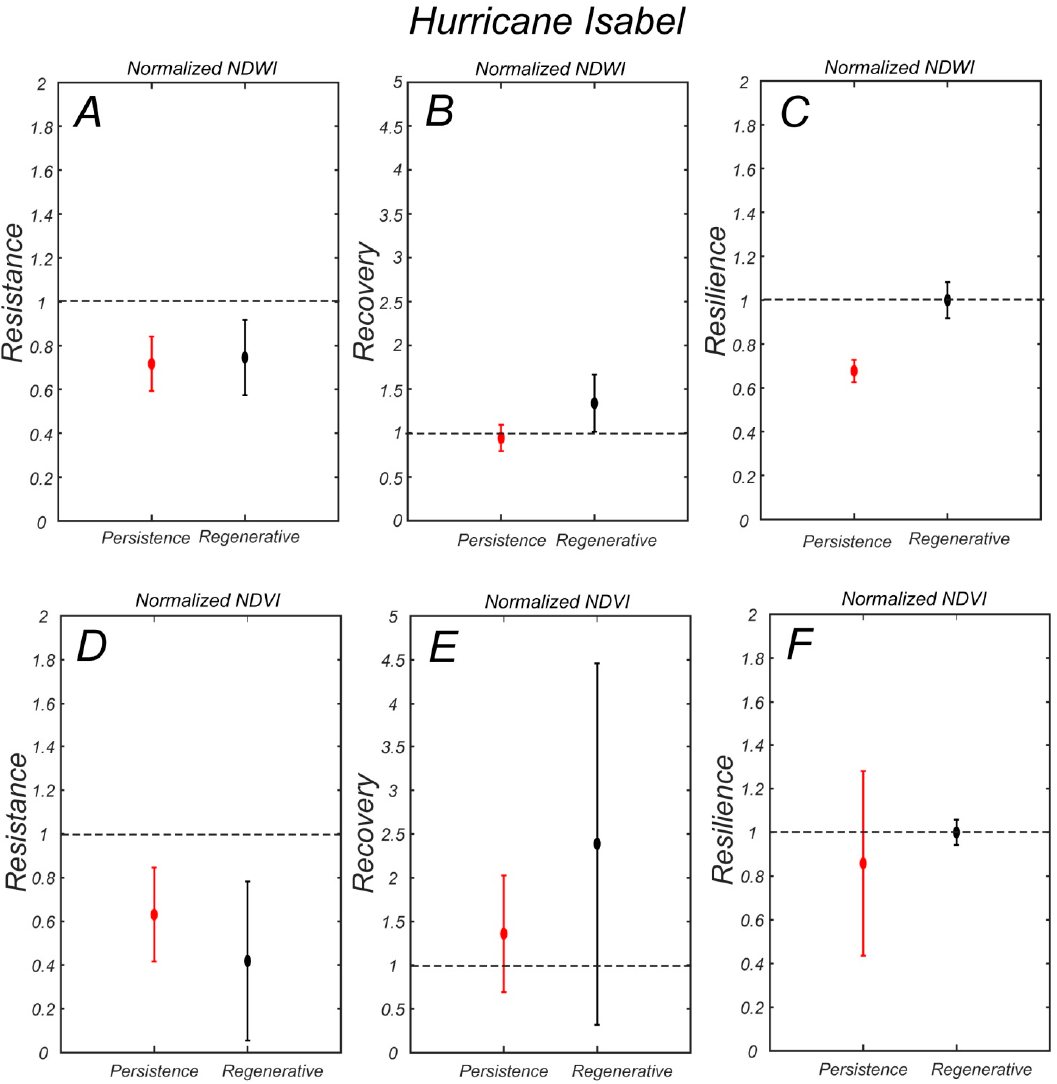
Figure 10. ( A ) Resistance, ( B ) recovery, and ( C ) resilience of persistence and regenerative zones computed with NDWI for Hurricane Isabel in 2003. ( D ) Resistance, ( E ) recovery, and ( F ) resilience computed with NDWI.